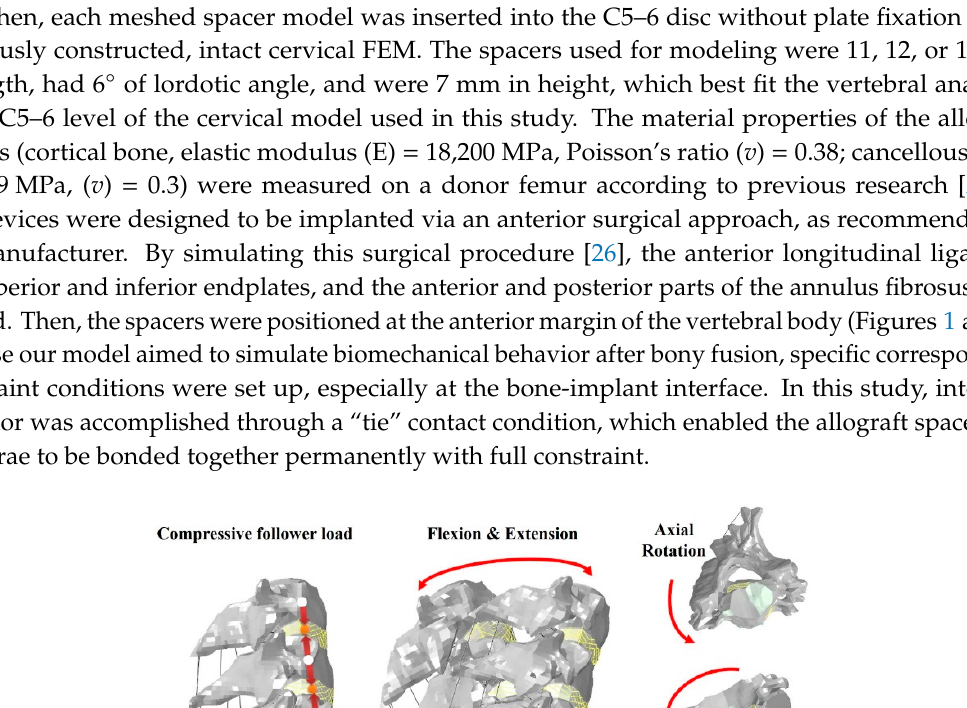
Figure 2. Finite element model of allograft spacers with hybrid motion control.